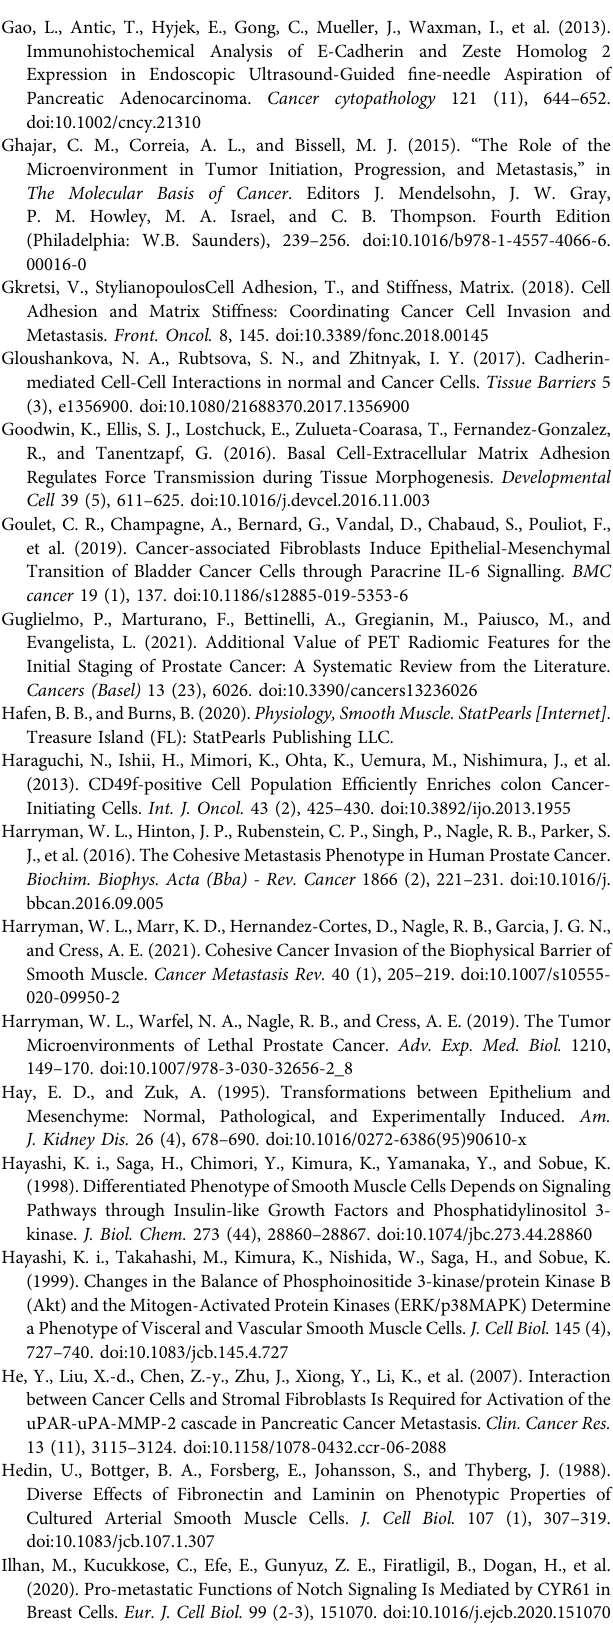
Frontiers in Cell and Developmental Biology |